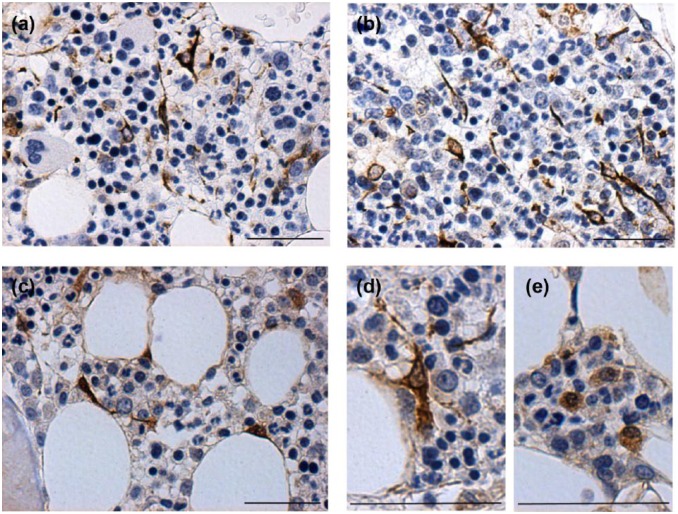
Vimentin and p16 expression in cells with stromal morphology. (a, b)
Vimentin-positive cells with elongated, spindle-shaped morphology were
noted to form a network within the marrow. (c, d) Cells expressing p16
in a predominantly nuclear distribution also had spindle-shaped
morphology and were distributed within hypocellular areas, (e) while
those with a more cytoplasmic pattern of staining were located in more
cellular areas of marrow.